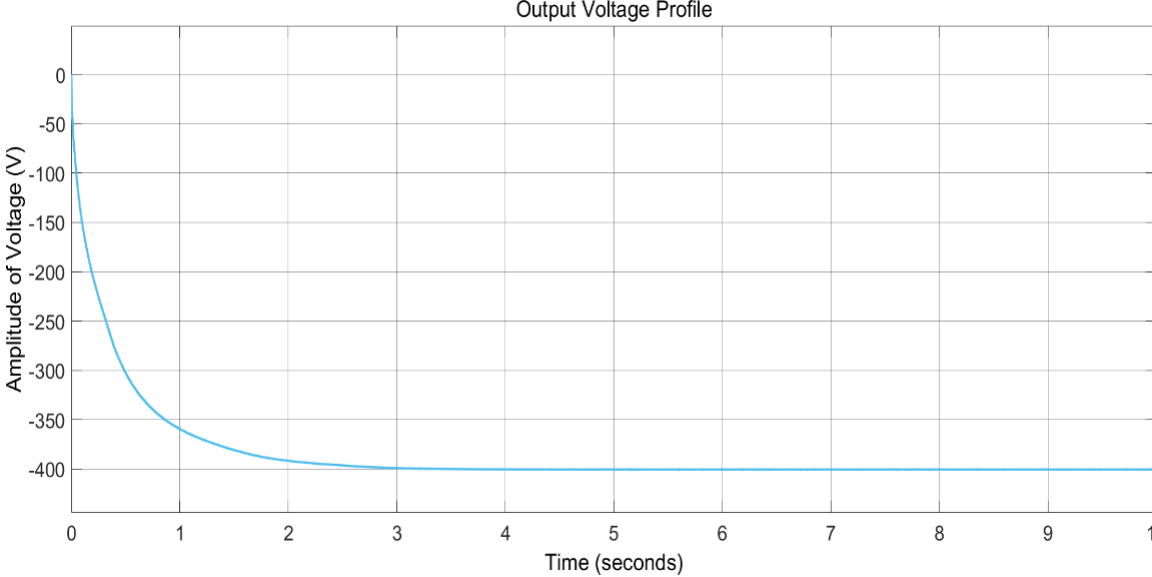
Figure 8. Sinusoidal input supply voltage and current.